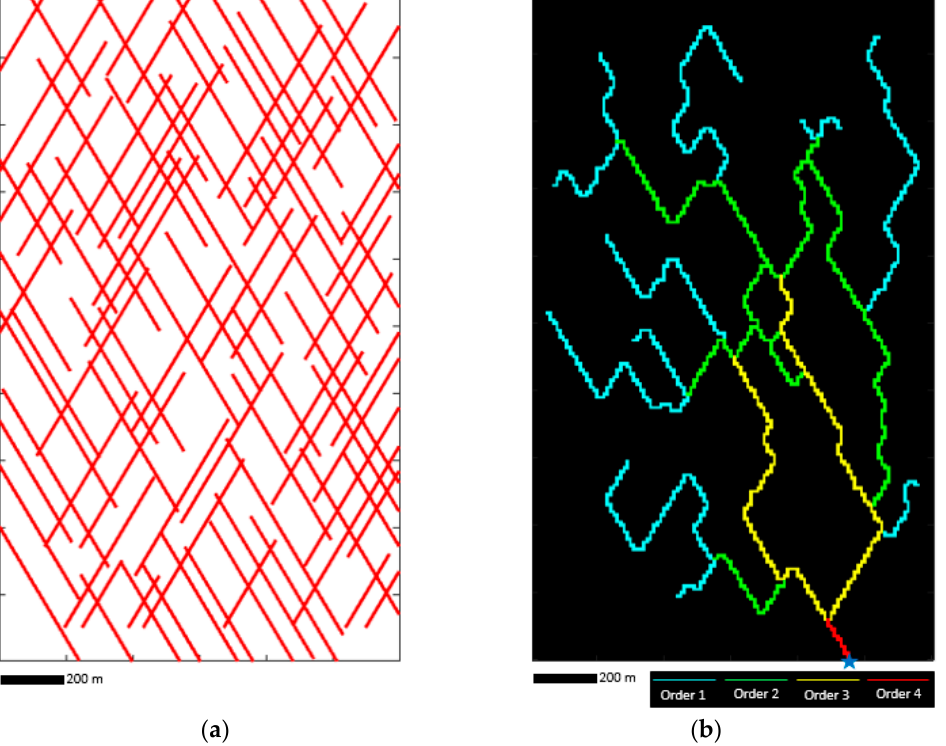
Figure 4. ( a ) The assumed random joint system and ( b ) the generated conduit network pattern with the order of conduits. The blue star is the seed cell (spring).